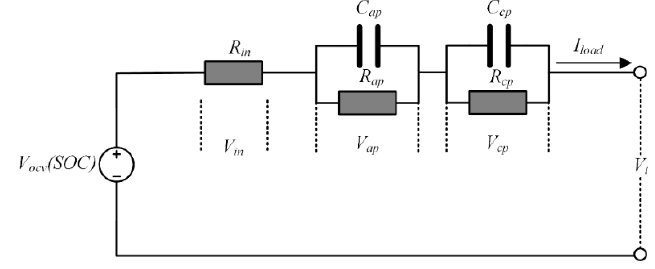
Figure 2. Schematic diagram of second order RC ARX battery model for lithium-ion battery.